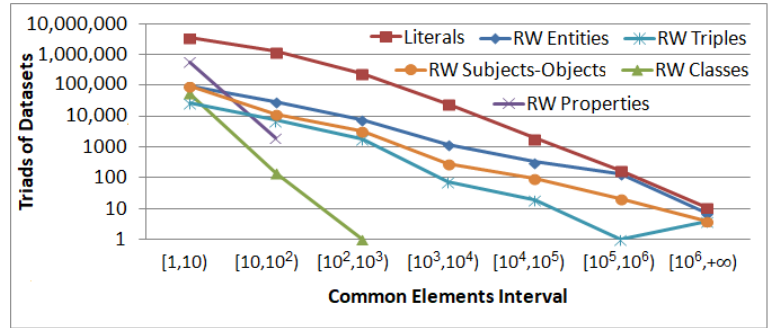
Figure 6. Number of connected triads of datasets per interval for each measurement type.